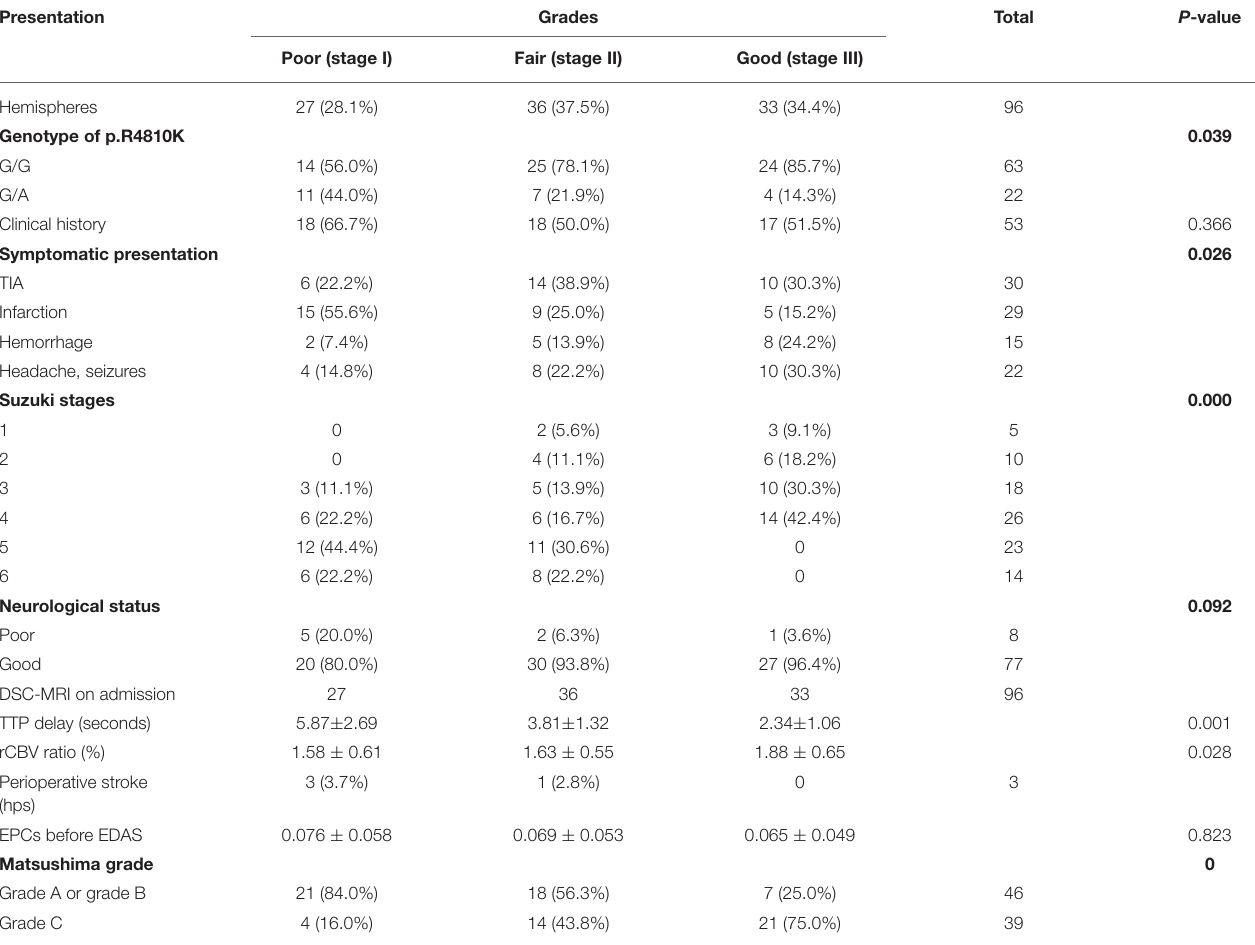
TABLE 2 | Classification of intracranial collateral circulation and clinical presentation in 96 symptomatic hemispheres.